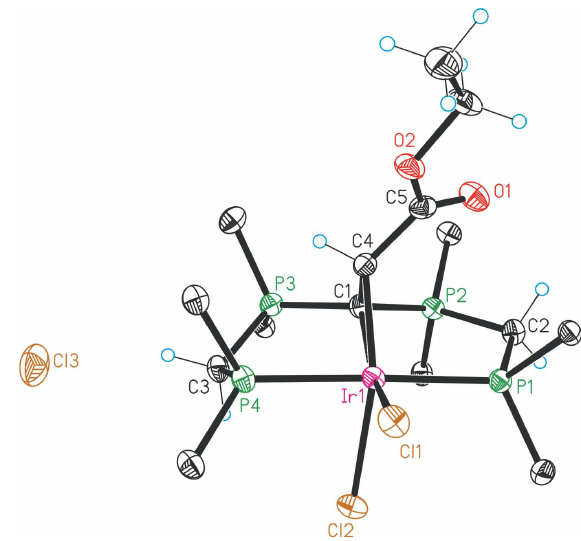
a P3—C1—P2 angle of 124.2 (3) (cid:3) . Overall, the transition metal